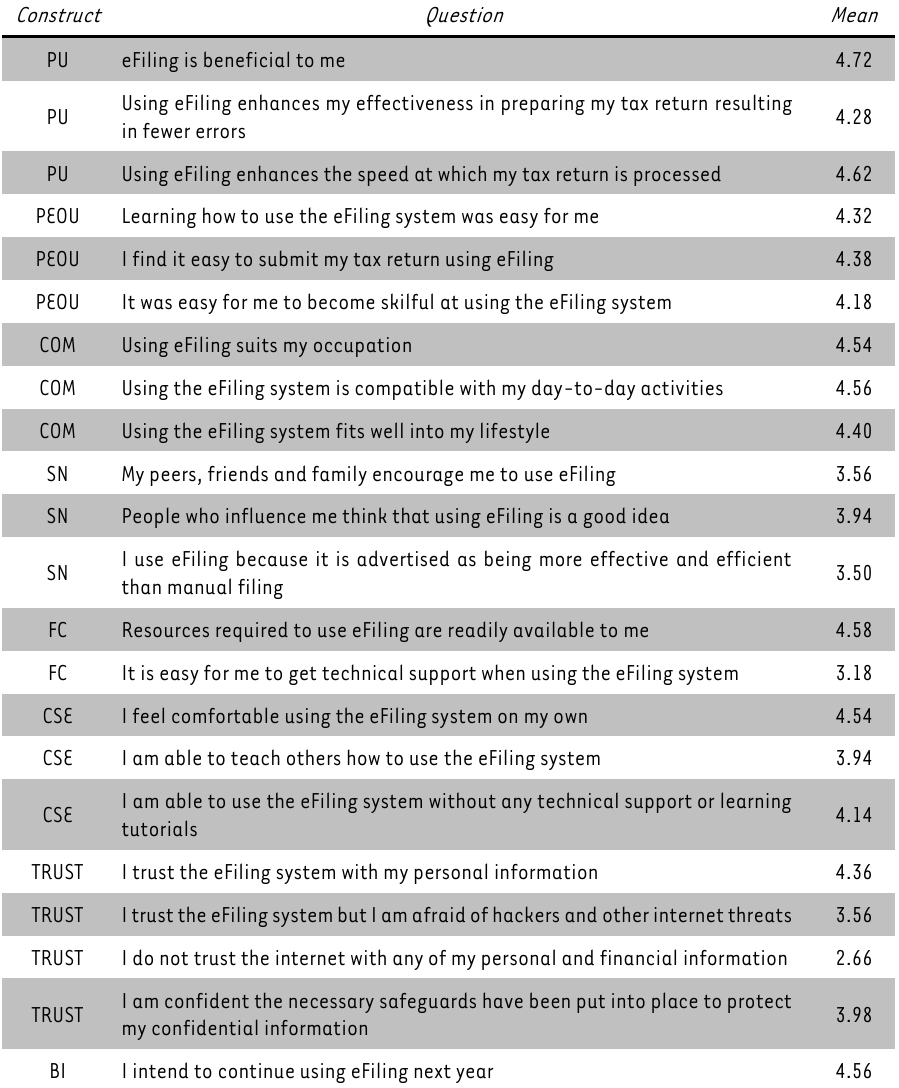
TABLE 3: Questions and results for electronic tax filers